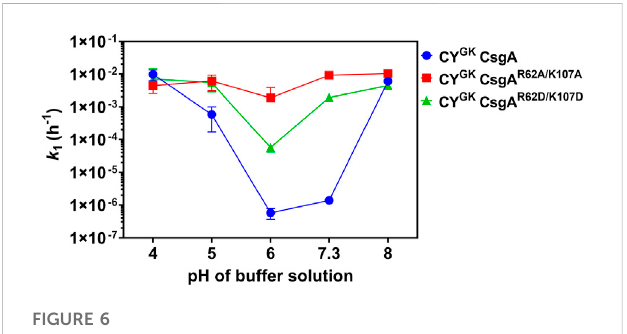
FIGURE 6 Comparison of the nucleation rates at different pH conditions. Nucleation rates k 1 (log scale) of CY GK CsgA (blue), CY GK CsgA R62A/K107A (red), and CY GK CsgA R62D/K107D (green) at different pH conditions at 37 ° C (Error bars represent SD for k 1 of three